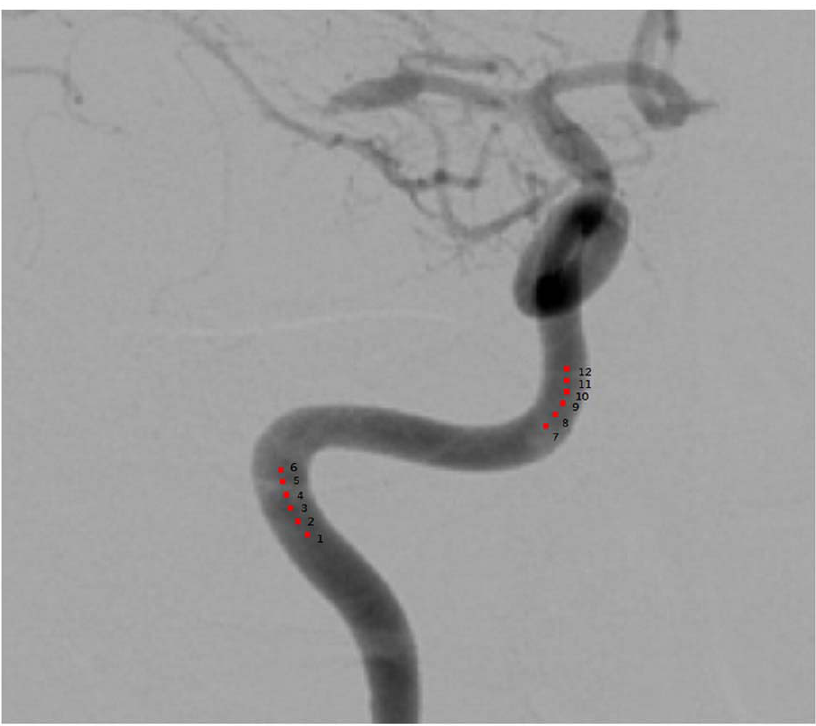
Figure 1. Selected ROI locations for flow estimation.